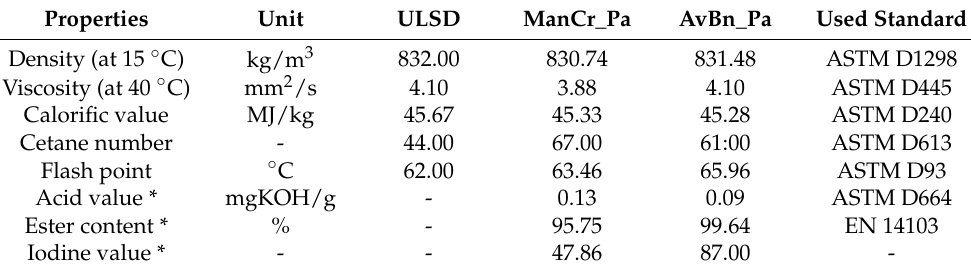
Table 3. Physiochemical properties of the tested